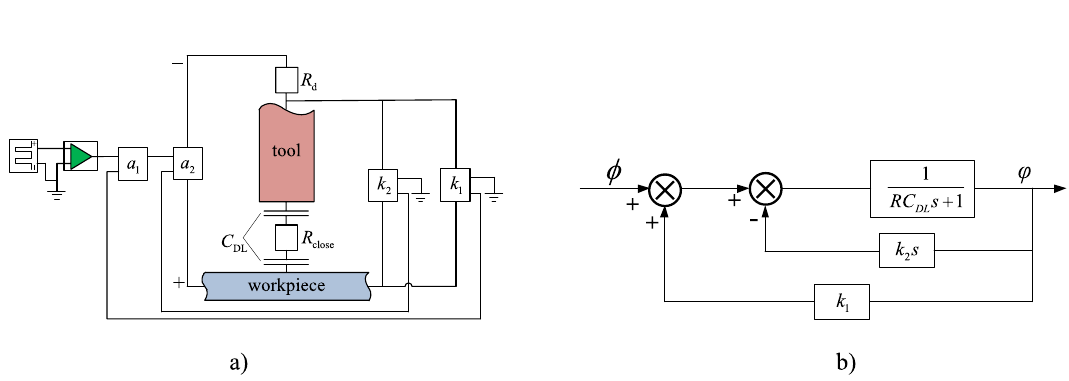
Figure 8. ( a ) Circuit of the machining system with double feedback loops; a 1 and a 2 denote adder; k 1 is an proportional amplifier, k 2 is an differential amplifier. ( b ) Block diagram of the equivalent